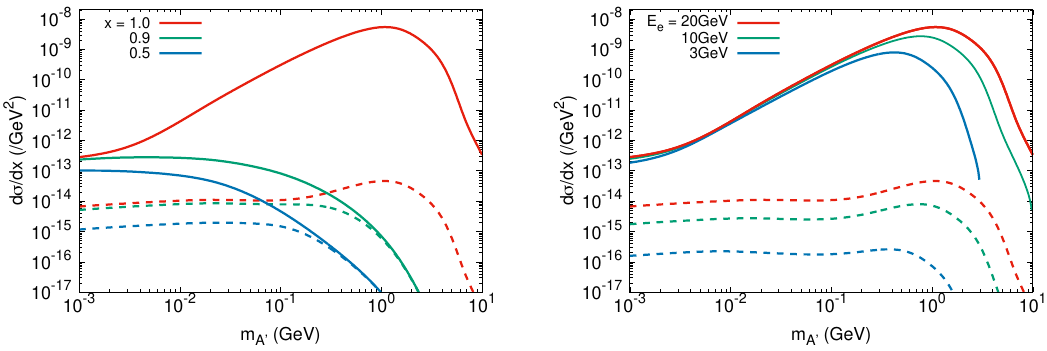
Figure 5 . The same plot as figure 2 for the dipole interaction. The coupling constants are taken to be µ e = µ 0 = 10 − 6 GeV − 1